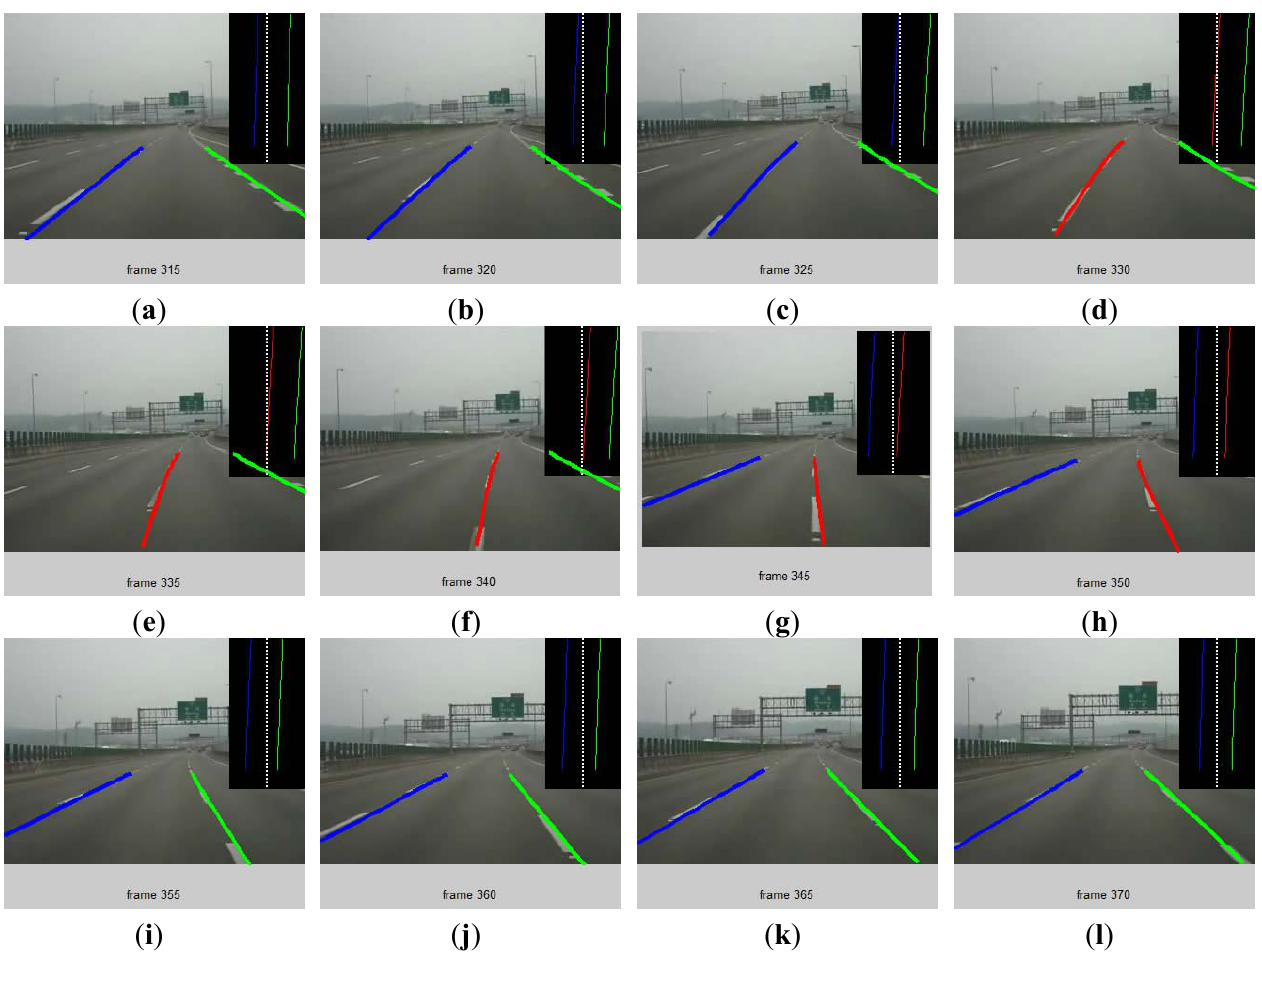
Figure 9. Continuous Images of a lane change